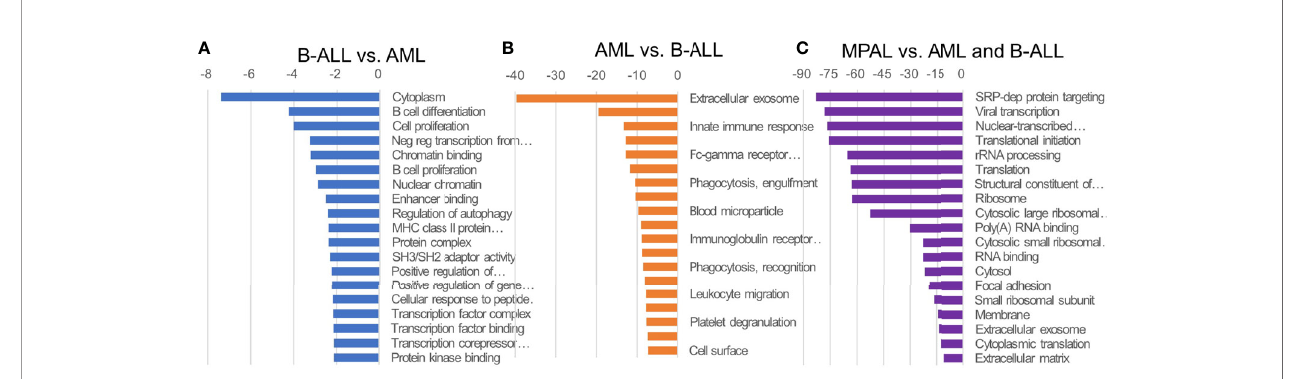
FIGURE 1 | GO of ALL, AML, and MPAL. General functional classi fi cation of highly expressed gene in B-lymphoblastic leukemia (B-ALL) compared to acute myeloid leukemia (AML) (A) , AML compared to B-ALL (B) , and in mixed-phenotype acute leukemia (MPAL) compared to B-ALL and AML (C) . Gene Ontology (GO) analysis within target genes of signi fi cantly altered transcripts was performed using the database for annotation, visualization and integrated discovery (DAVID) bioinformatics tool. Enriched GO biological processes were identi fi ed and listed according to their enrichment P value (P < 0.05) and false discovery rate (FDR < 0.25). Both P and FDR values were obtained using DAVID 2.1 statistical function classi fi cation tool. scale: -log 10